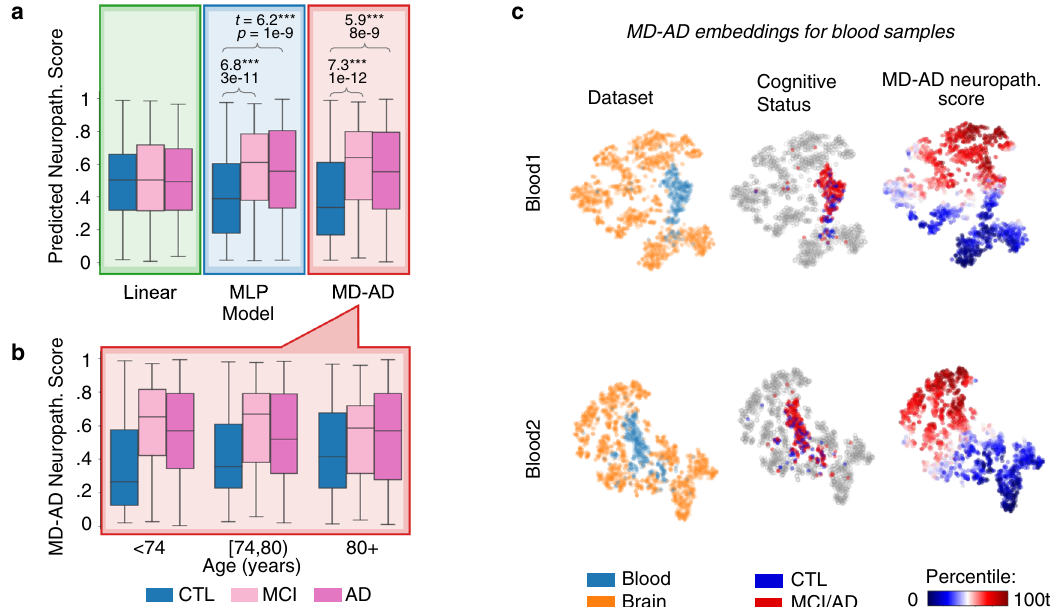
Fig. 7 MD-AD ’ s transfer performance for blood gene expression datasets. a Box plots show neuropathology predictions from each method split by cognitive status. From left to right, individuals who are cognitively normal (CTL), have mild cognitive impairment (MCI), and Alzheimer ’ s dementia (AD). T tests highlight signi fi cantly different groups within each method (two-sided t test, *** p < 0.001). All box plots in this fi gure indicate median (center line), upper and lower quartiles (box limits), 1.5× interquartile range from quartiles (whiskers), and outliers (points). N = 238 CTL, 189 MCI, 284 AD samples. b Box plots show the differences in MD-AD predicted neuropathology samples from individuals strati fi ed by age group and cognitive status (signi fi cant differences are shown in Supplementary Figure 12b; n = 238 CTL, 189 MCI, 284 AD samples) (same box plot elements as described in part a). c t-SNE embedding of last shared layer from MD-AD models trained for Blood1 and Blood2 datasets. Samples are colored by their dataset (left), cognitive status (while brain samples are shown in gray; middle), and predicted neuropathology score